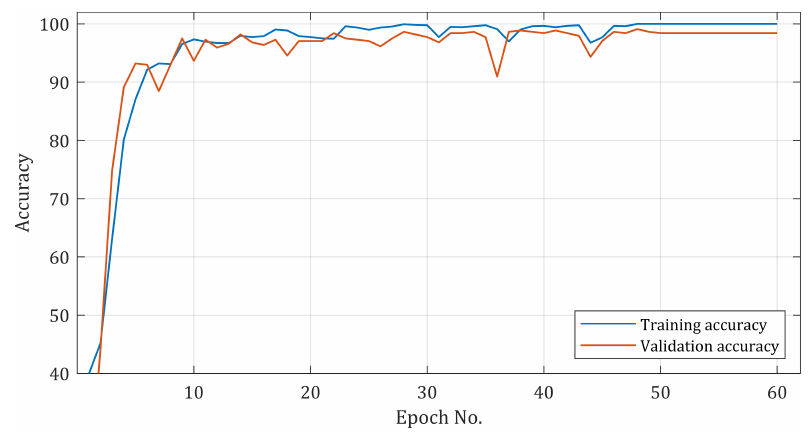
Figure 11. Accuracy of the training